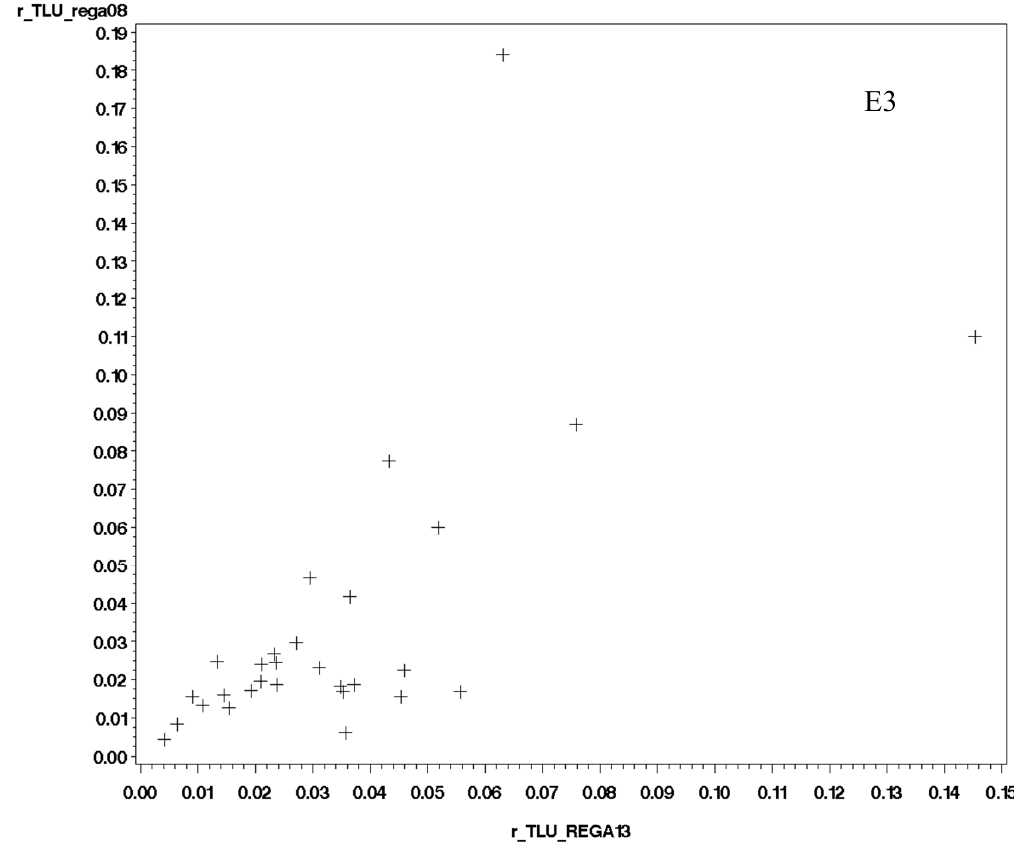
Figure A5. Scatter plots of relative number of heads for TLU (E1–E3).